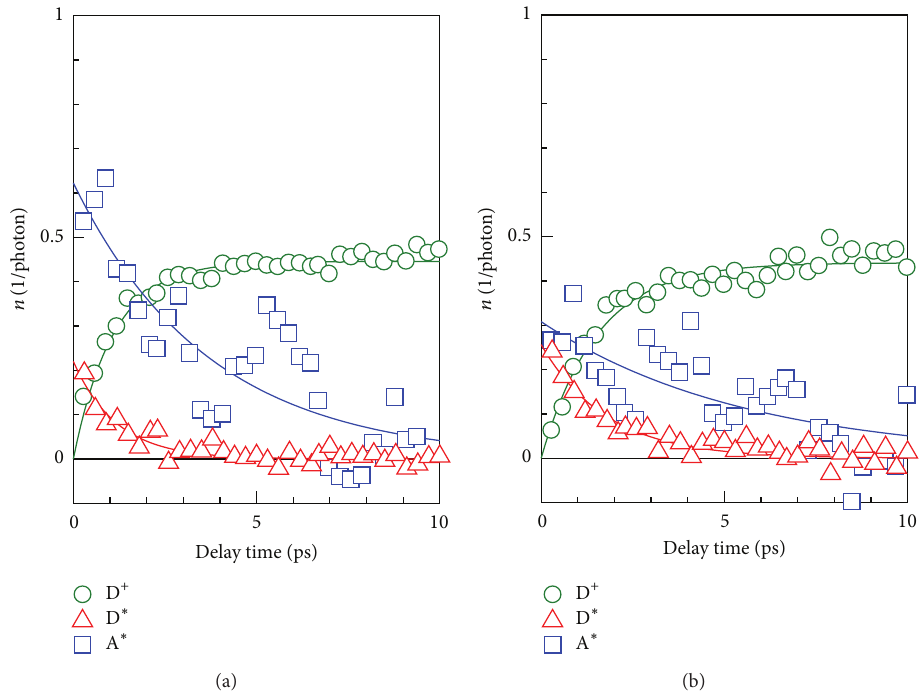
Figure 14: 𝑛 D + , 𝑛 D ∗ , and 𝑛 A ∗ per an absorbed photon against the delay time in PTB7 (100nm)/C 70 (25 nm) bilayer film at (a) 300 K and (b) 80 K. Adjacent averages were plotted in 𝑛 A ∗ . The solid curves are results of the least-squares fittings with exponential